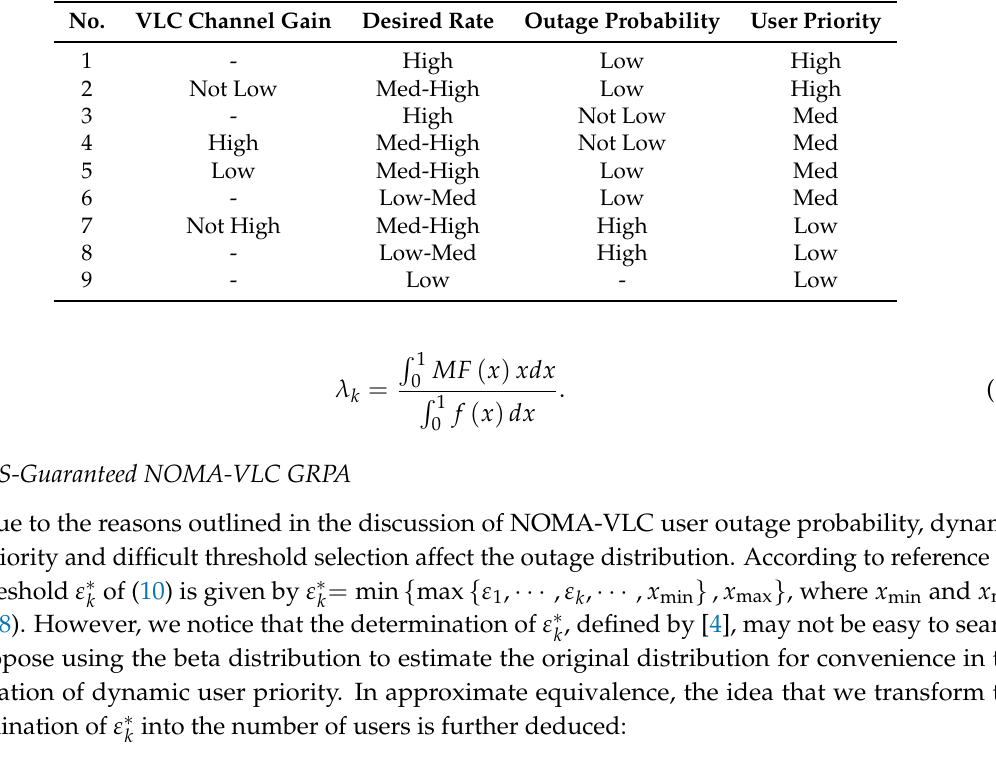
Table 2. Fuzzy rule